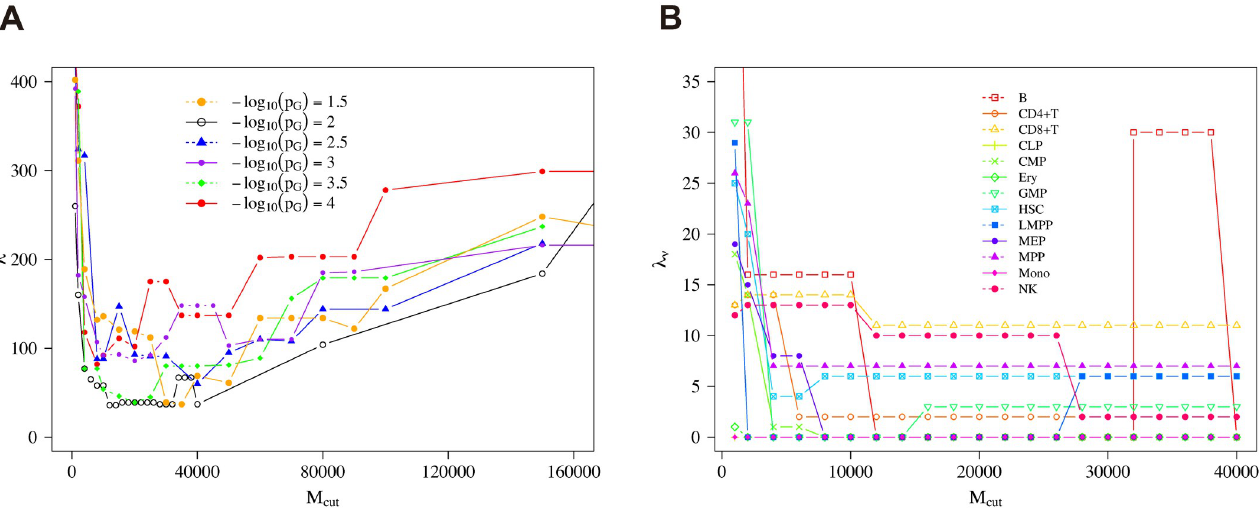
Fig 13. Penalty by UPGMA method. The distribution of global penalty λ (A) and type penalty λ 10 − 2 by using UPGMA.